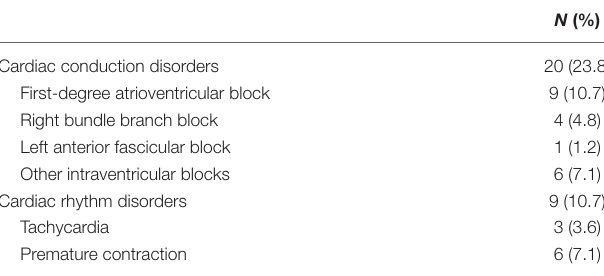
TABLE 3 | Types of cardiac abnormalities in patients with